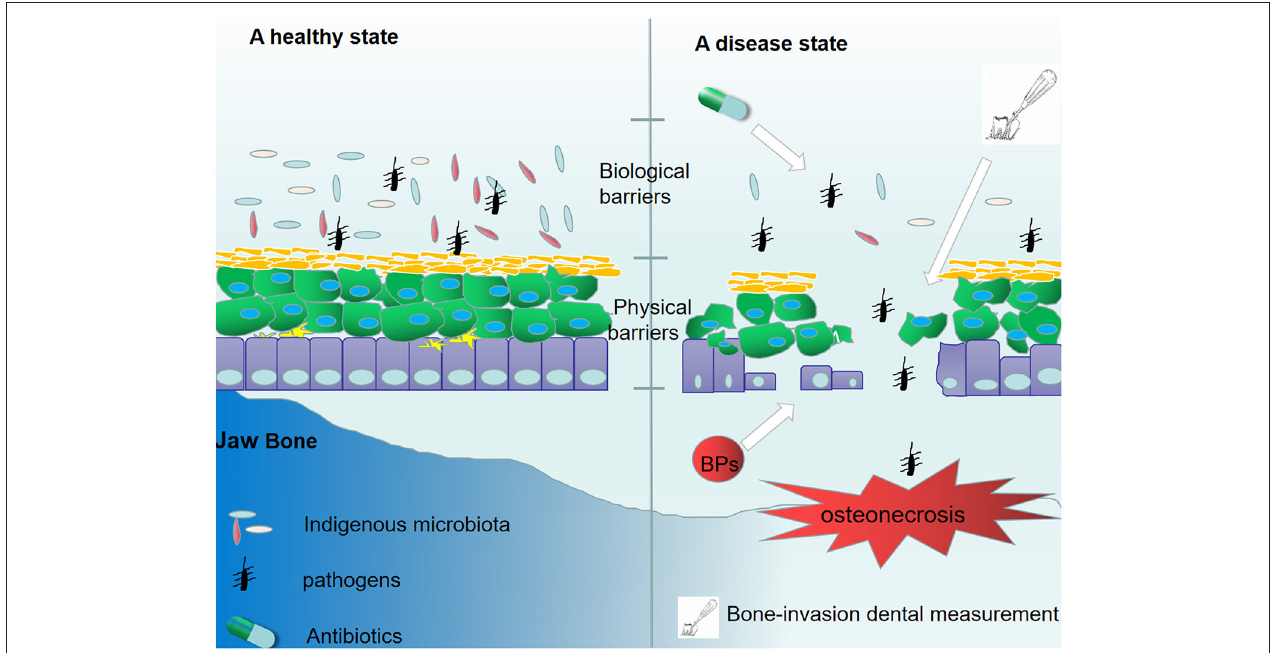
FIGURE 1 | The destruction of mucosal barrier protection. In a healthy state, indigenous microbiota and epithelial cells suppressed the invasion of pathogens. However, the long-time administration of antibiotics disturbs the oral normal flora, leading to a loss of biological barriers. Additionally, treatment with BPs and some bone-invasion dental measurements destroy the physical barrier composed by epithelial cells. The destruction of mucosal barrier protection facilitates bacterial invasion and colonization.